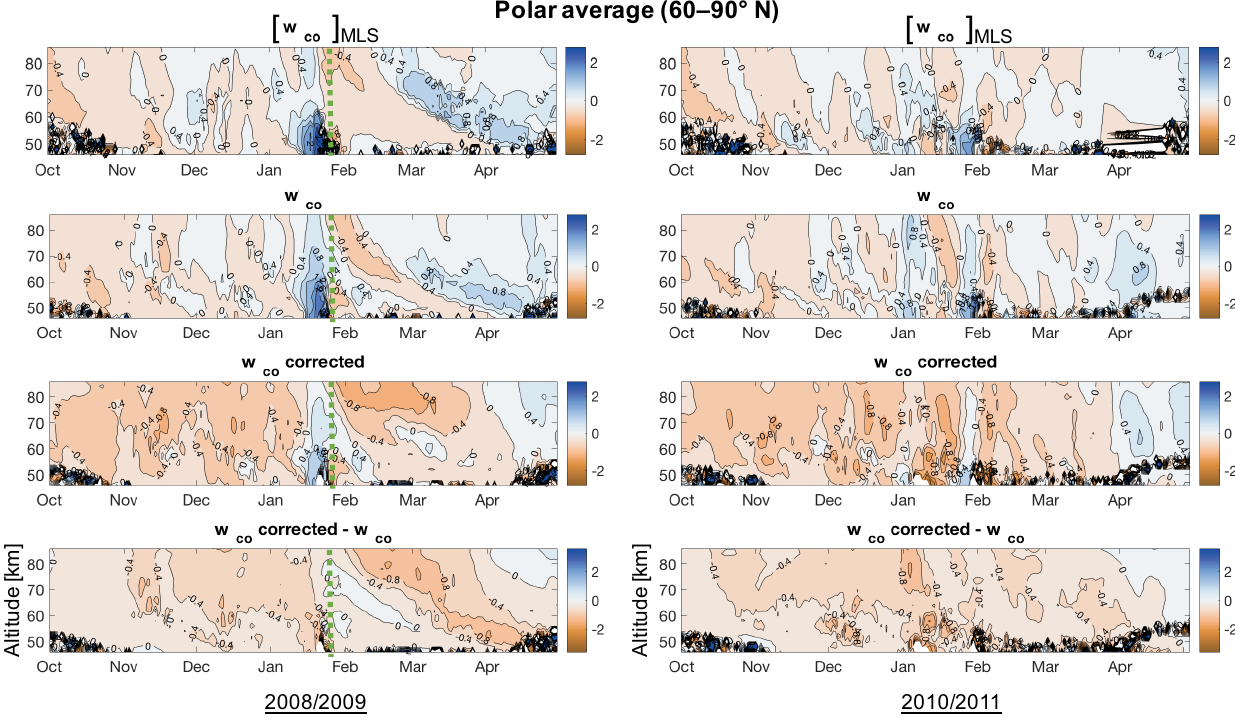
Figure 8. The same as Fig. 6, but for the north polar average (60–90 ◦ N), and including rates calculated using MLS CO data in the upper panel, titled [ w CO ] MLS